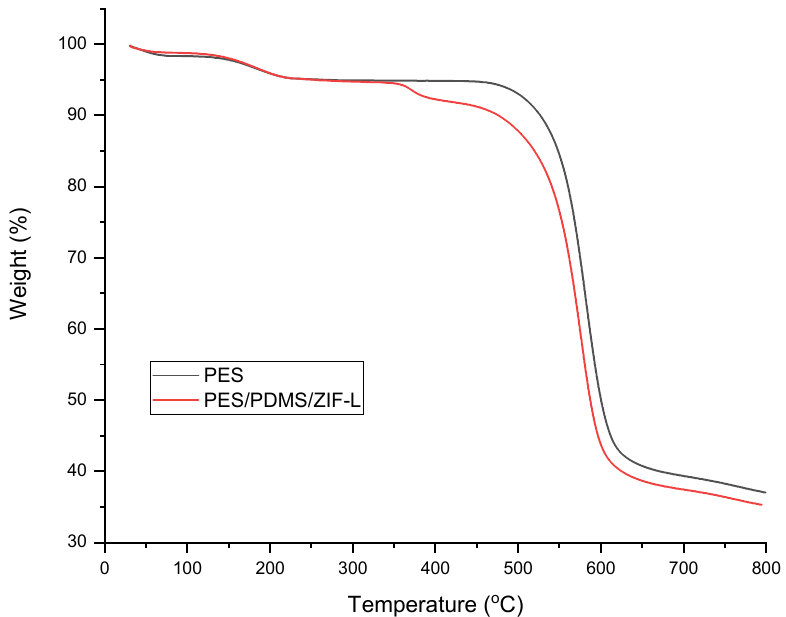
Figure 9. TGA analysis of PES and ZIF-L@PDMS/PES membranes.